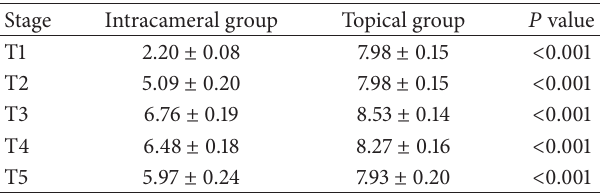
Table 1: Pupil size (mm) at different stages of surgery in the two groups (mean ±